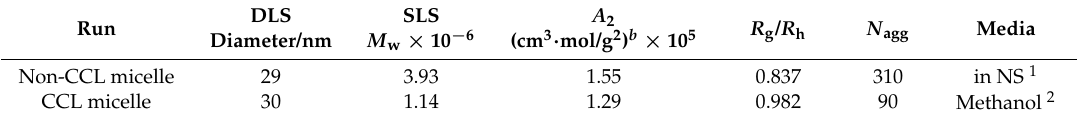
Table 4. Diameter, weight-average molecular weight ( M w ), second virial coefficient ( A 2 ), radius of gyration ( R g ), and aggregation number ( N agg ) of non-core crosslinked (CCL) and CCL micelles.